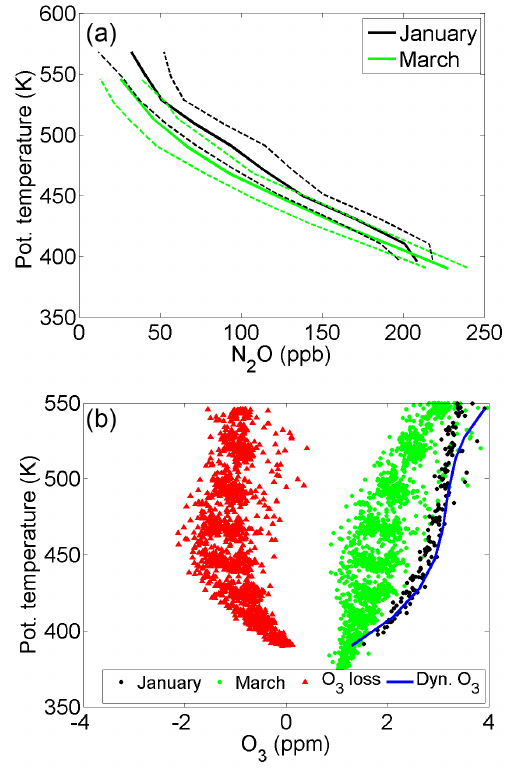
Figure 2. (a) shows the monthly average N 2 O profiles observed by ACE-FTS inside the polar vortex in January (black line) and March (green line) 2011 together with the respective standard deviations (shown as dashed lines). (b) displays the observed ACE-FTS ozone in January (black dots) and March (green dots) 2011, the passive ozone (blue line) for March 2011, estimated from the average vortex profile descent from N 2 O, and the ozone loss (red triangles; the difference between observed and average passive ozone in